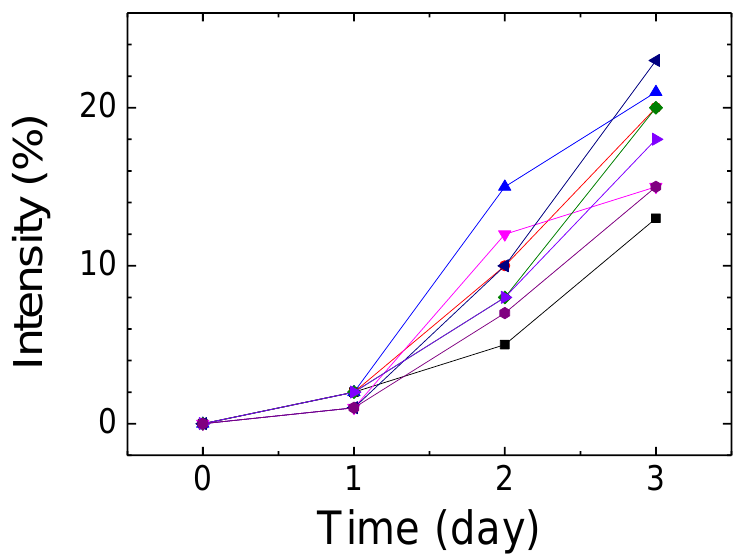
Figure 7. The transmittance intensity of Bragg’s reflection of the cholesteric liquid crystal (CLC) biosensor with time in different patients suffering from spontaneous subarachnoid hemorrhage